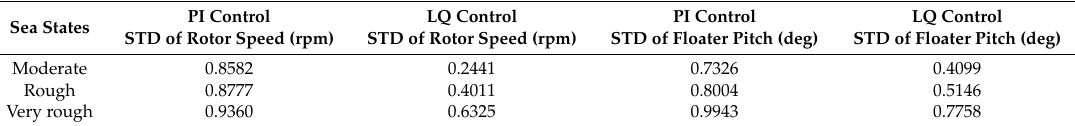
Table 3. Proportional-integral (PI) and LQ control performance: standard deviations of rotor speed and floater pitch.